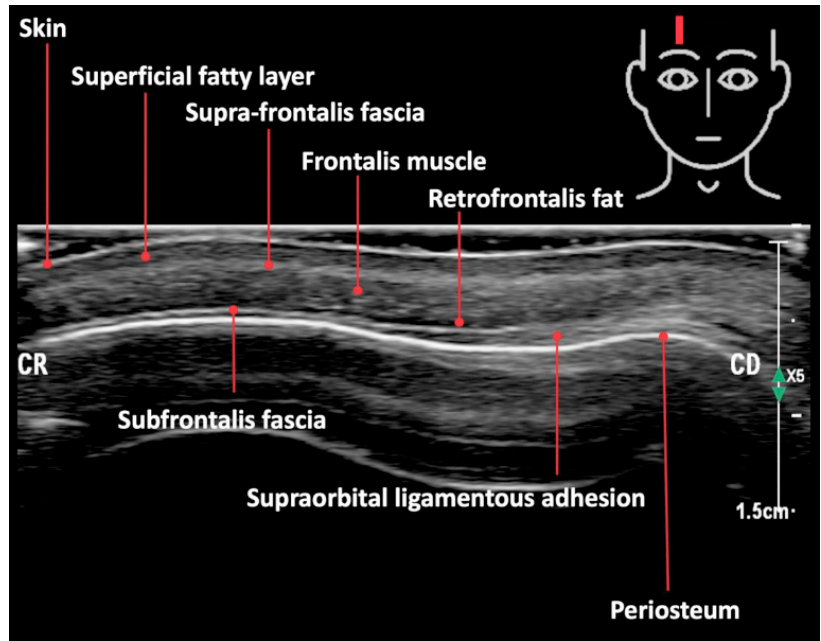
Figure 4. Ultrasound image depicting the layered forehead anatomy in a 45-year-old female Cauca- sian patient [34].